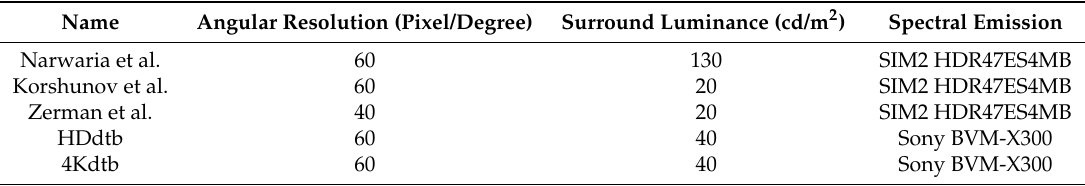
Table 3. Parameters used for